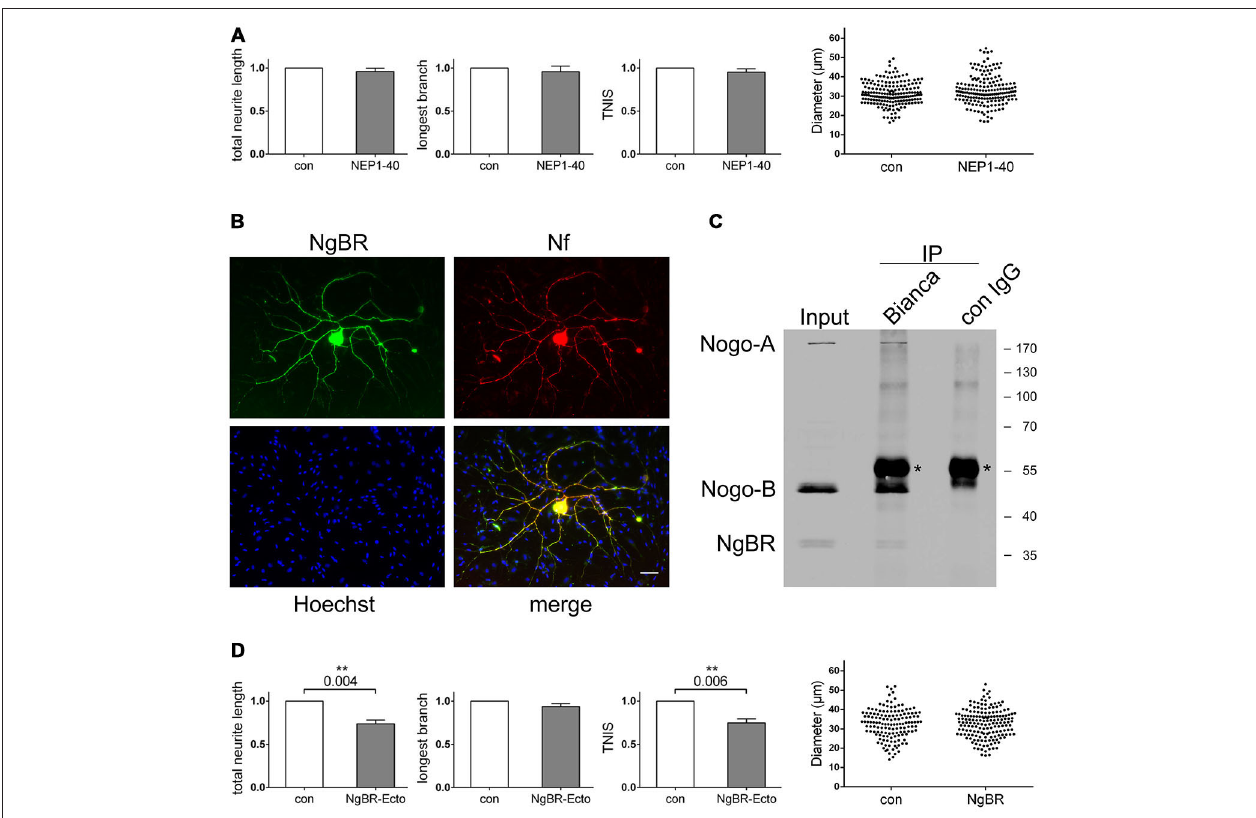
FIGURE 5 | Blocking the Nogo-B receptor NgBR mimics the loss-of-nogo branching phenotype. (A) Quantification of morphological parameters of adult wildtype sensory neurons grown on wildtype Schwann cells in the presence or absence of NEP1–40. Five independent experiments were carried out with a total of 181 neurons being analyzed in the control and 177 neurons in the NEP1–40 group. Morphological parameters were normalized to the control (PBS; set to 1.0) and expressed as mean ± SEM. P -values ≤ 0.05 are indicated. Neuronal cell body diameters are depicted in a dot blot. (B) Immunocytochemistry of a Schwann cell neuron co-culture stained for NgBR, Hoechst and neurofilament. Scale bar is 10 µ m. (C) Co-immunoprecipitation experiments with a co-culture of wildtype Schwann cells and nogo-a/b deficient sensory neurons. For pull-down Bianca antiserum or a rabbit control IgG was used. Detection was done with Bianca antiserum and an NgBR antibody. Asterisks indicate the rabbit IgG heavy chain that is detected by the secondary anti-rabbit antibody. (D) Quantification of morphological parameters of adult wildtype sensory neurons grown on wildtype Schwann cells in the presence or absence of NgBR-Ecto. Five independent experiments were carried out with a total of 142 neurons being analyzed in the control and 167 neurons in the NgBR-Ecto group. Morphological parameters were normalized to the control (50% glycerol in PBS; set to 1.0) and expressed as mean ± SEM. P -values ≤ 0.05 are indicated. In the presence of NgBR-Ecto TNIS is reduced to 0.75 and TNL to 0.74 relative to the control levels. Neuronal cell body diameters are depicted in a dot blot.